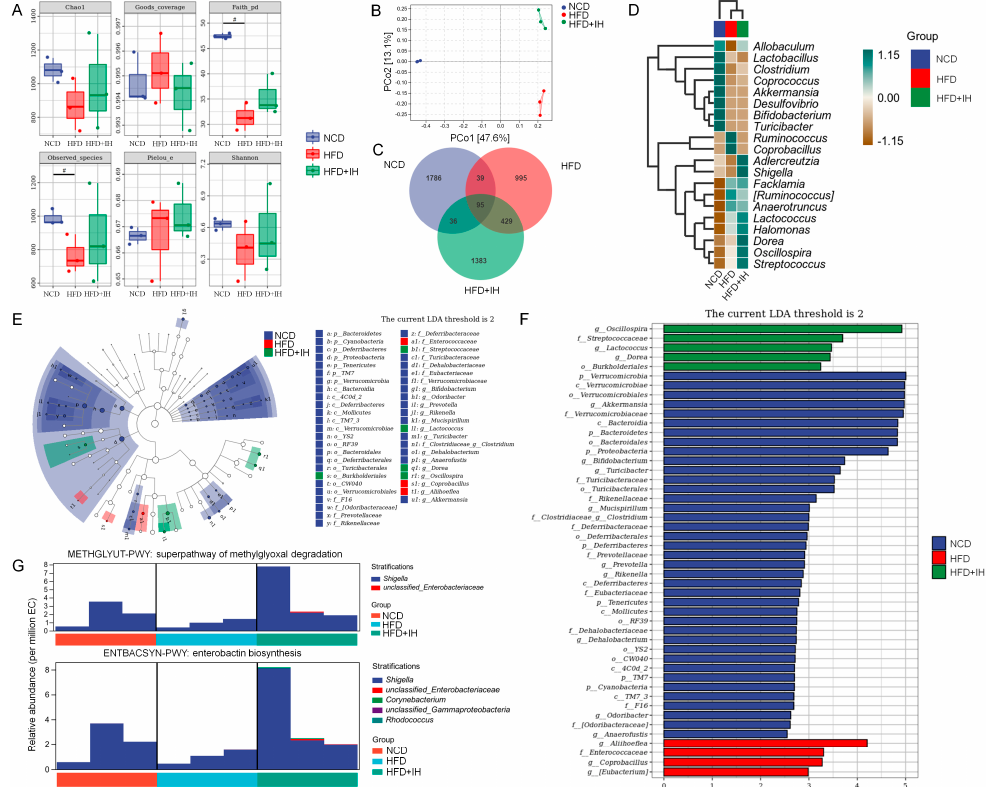
Figure 3. IH regulated the intestinal microflora. ( A ) Chao1, Shannon, Pielou’s evenness, observed species, Faith’s PD, and Good’s coverage index values from alpha diversity analysis among vehicle- treated NCD-fed mice, vehicle-treated HFD-fed mice, and IH-treated HFD-fed mice ( n = 3). # p < 0.05 versus vehicle-treated NCD-fed mice. ( B ) PCoA of unweighted UniFrac distance from beta diversity analysis. ( C ) Venn diagram. ( D ) Heatmap of the top 20 genera by average abundance, using UPGMA clustering according to the Euclidean distance of species composition. ( E ) Taxonomic cladogram and ( F ) histogram of distribution of LDA values of significantly different species according to LefSe analysis. ( G ) Species composition in significantly different metabolic pathways via